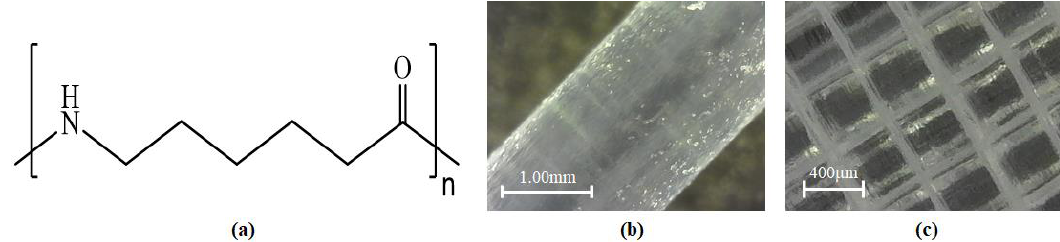
Figure 11. Nylon ( a ) chemical structure; ( b ) raw material; and ( c ) final processed material.